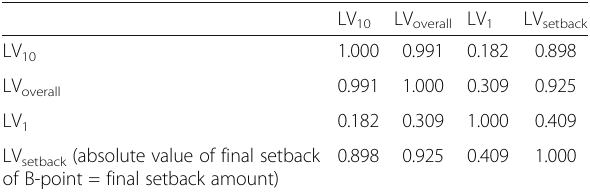
Table 4 Correlations between latent variables